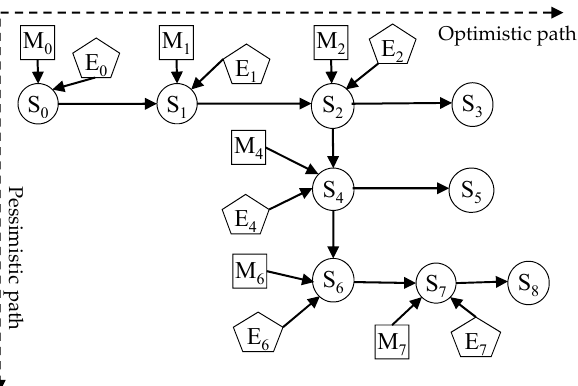
Figure 5. Xiantao waste NIMBY crisis scenario evolution path. (Note: “E” means external situation, “S” means scenario state, and “M” means emergency management.).